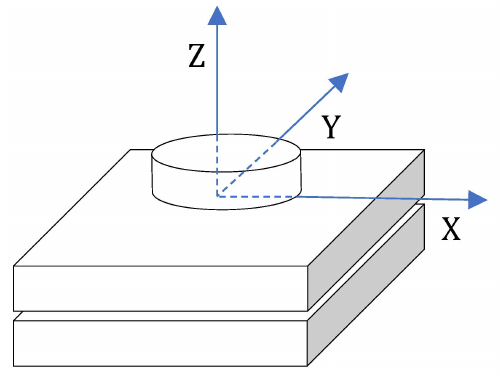
Figure 2. Contact stethoscope and simulation surface.